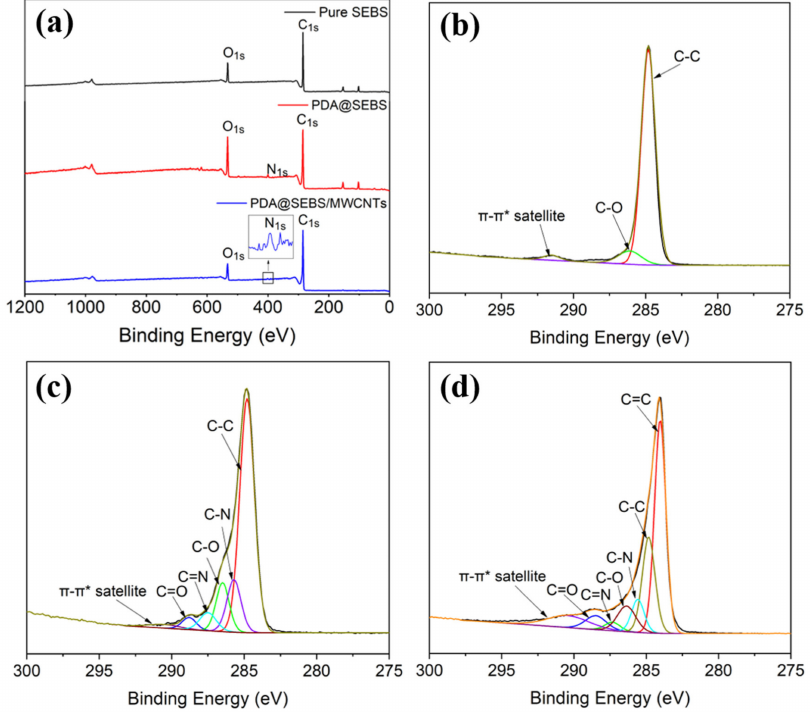
Figure 5. ( a ) XPS wide scan spectra of pure SEBS, PDA@SEBS and PDA@SEBS/MWCNTs. C 1s core-level spectra of ( b ) pure SEBS, ( c ) PDA@SEBS, ( d )